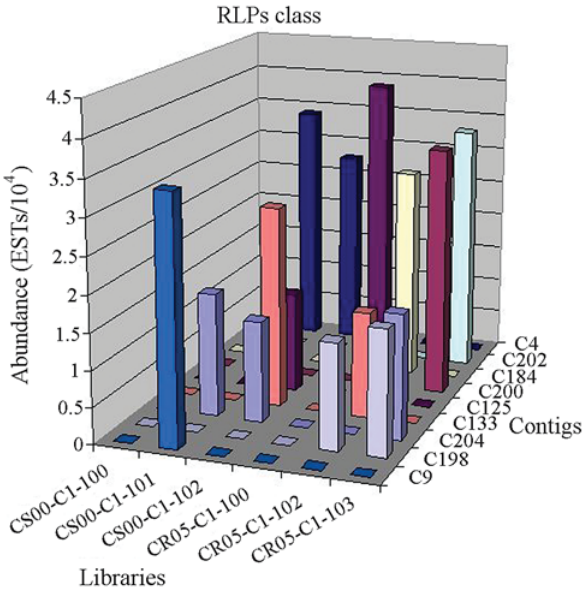
Figure 6 - Transformed data representing the relative abundance of EST by library, expressed in 10 4 reads, in contigs related to RLPs class. CS: Citrus sinensis ; CR: Citrus reticulata ; PT: Poncirus trifoliata ; C1: leaf cDNA; 100: non-infected material; 101: infected with Xylella fastidiosa ; 102: 30 days after X. fastidiosa infection; 103: 60 days after X. fastidiosa